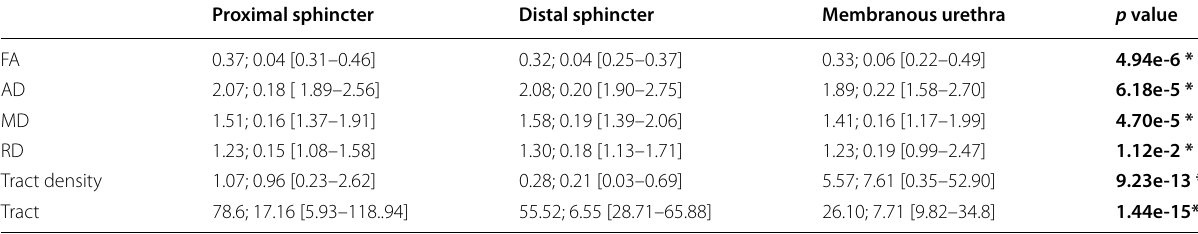
Tract density is expressed in tracts/mm3; Tract length in millimeters (mm); Diffusivity measures—AD, MD, and RD—in 10–3 mm2/s; FA is dimensionless. ANOVA (or the nonparametric Kruskal–Wallis test *) p values for the comparison of each DTI metric between regions are shown on the last column—statistically significant results are highlighted in bold